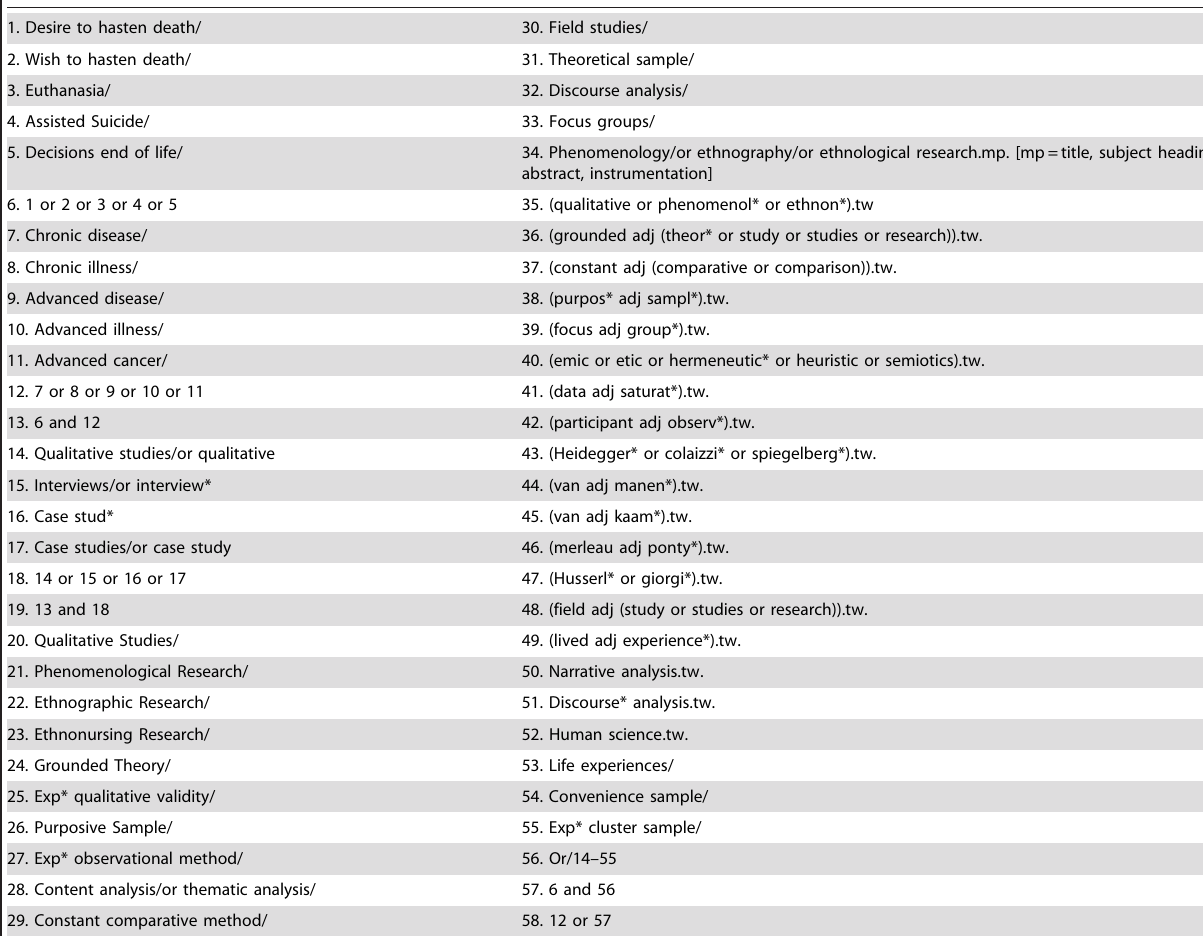
Table 1. Final database search